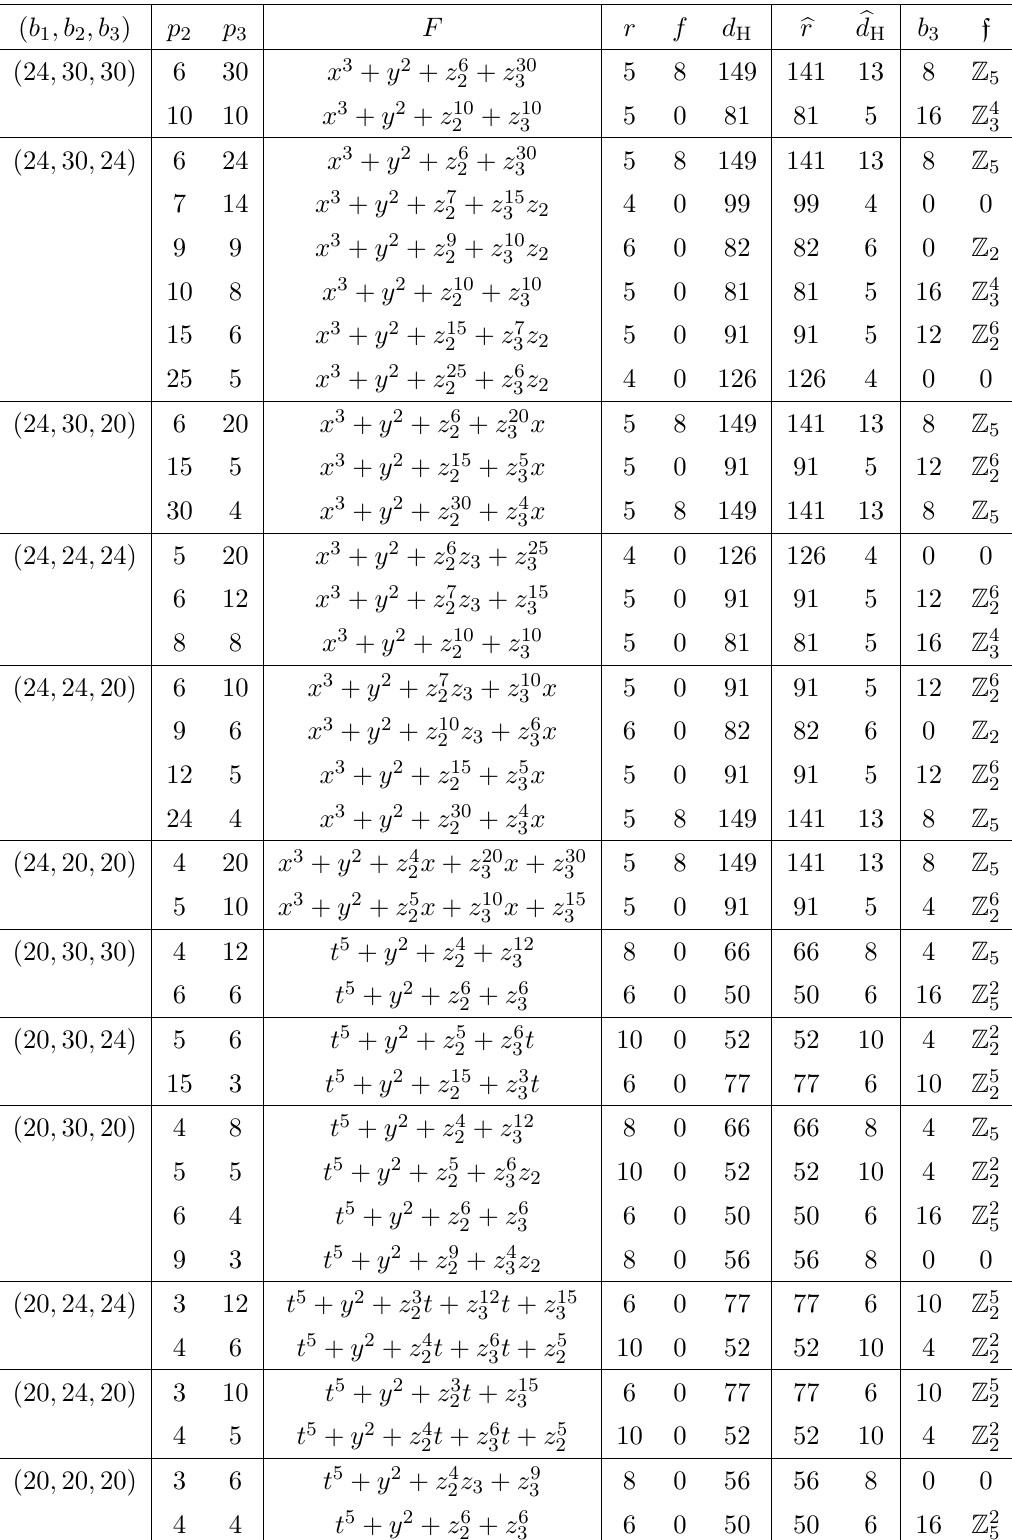
Table 23 . G = E 8 models with b 1 = 20 , 24